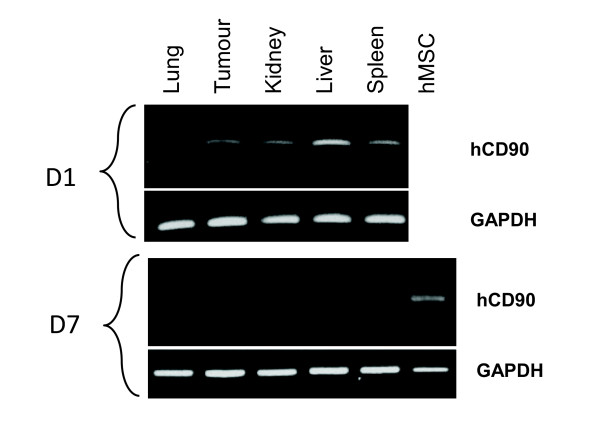
Detection of hMSCs at different timepoints after IV injection. Different tissues/organs were collected at various timepoints (day 1 (D1) and 7 (D7); n = 3) after the infusion of hMSCs. RNA was extracted from these tissues and analysed by RT-PCR. Human-specific CD90 (hCD90) and GAPDH mRNA expression were detected by electrophoresis in a 2% agarose gel (hCD90 product size: 139 bp, GAPDH product size: 170 bp). bp, base pair; hMSCs, human mesenchymal stem cells; IV, intravenous; RT-PCR, reverse-transcriptase polymerase chain reaction.